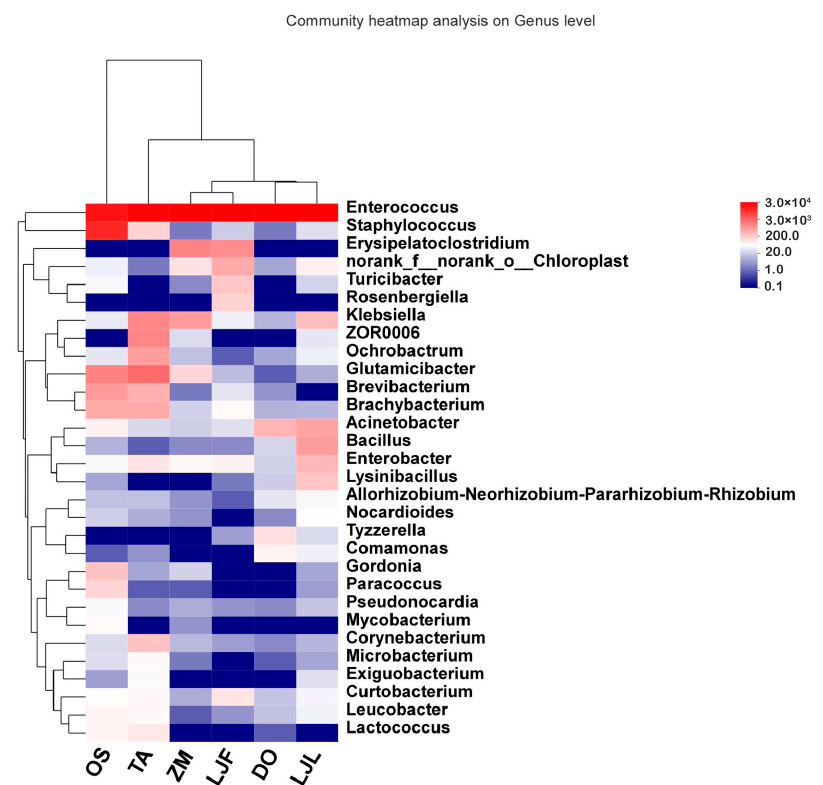
Figure 3. Heatmap of the top 30 most abundant genera in the bacterial community of Spodoptera frugiperda fed on different hosts. Abbreviations in the figure represent different treatments: ZM, maize; TA, wheat; OS, rice; LJF, honeysuckle flowers; LJL, honeysuckle leaves; and DO, Chinese yam. The columns represent the samples and rows represent the bacterial at the genus level. The color scale represents the normalized values of relative abundances by log10.